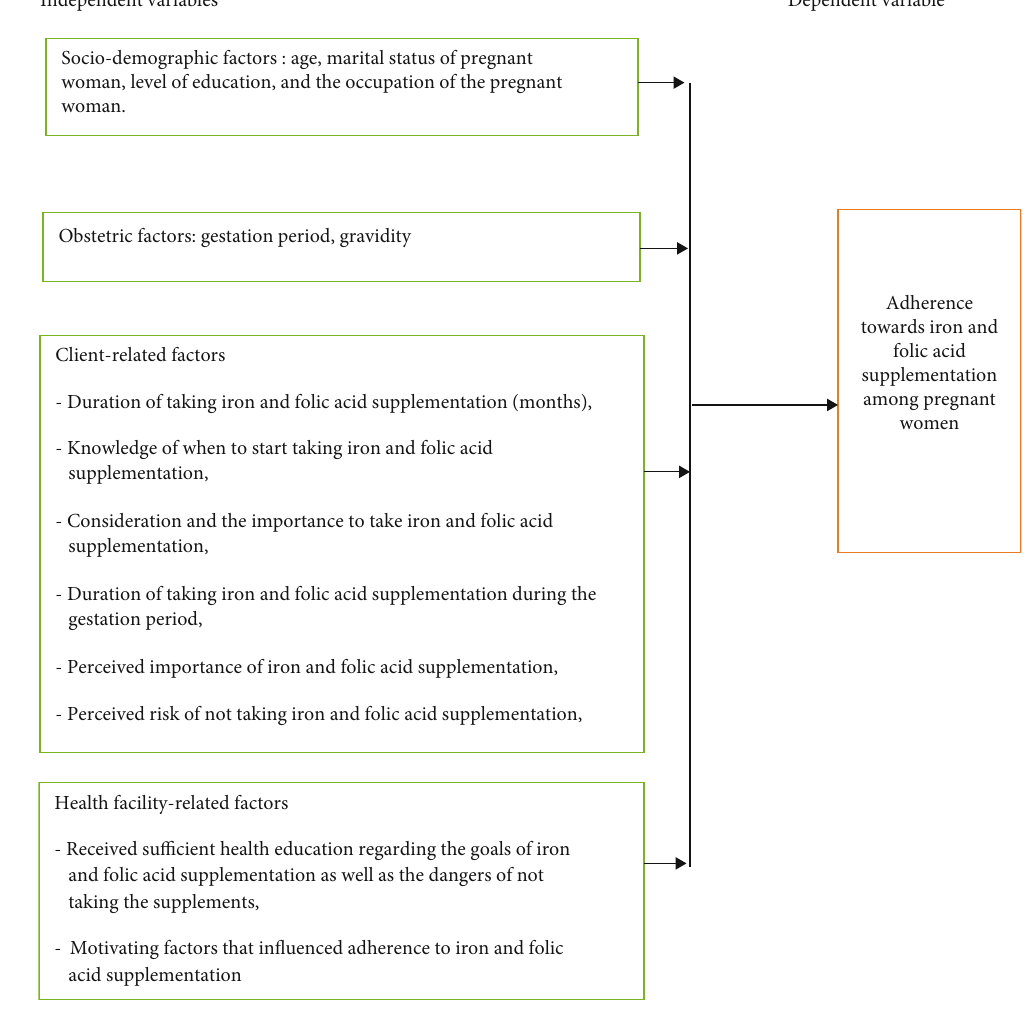
Figure 1: Conceptual framework developed from di ff erent literature [3, 9 –